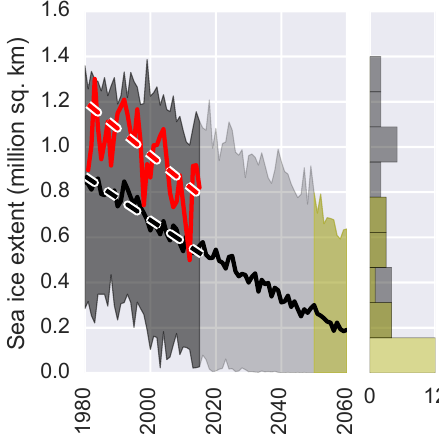
Figure 13. Observed (red line) September sea ice extent over Cana- dian marine regions (SIC > 0.15): CMIP5 multi-model mean (black line) and spread (shading). Histogram on the right shows the model distribution for 1980–2015 in black and for 2050–2060 in